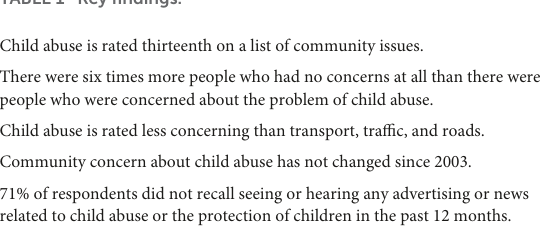
TABLE 1 Key findings. TABLE 2 Key